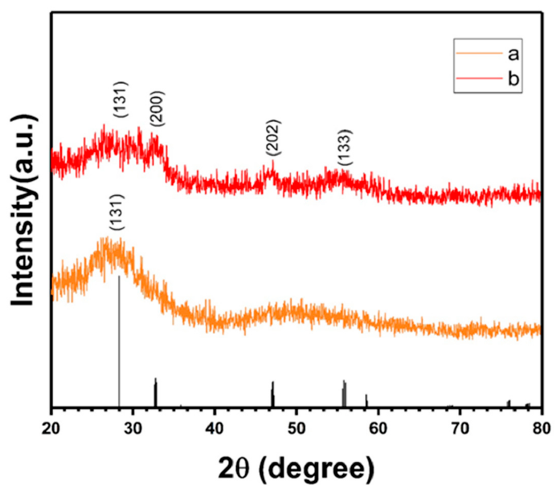
Figure 7. X-ray diffraction (XRD) spectra of ( a ) G/PDA/BWN P ( b ) G/BWP/PDA.